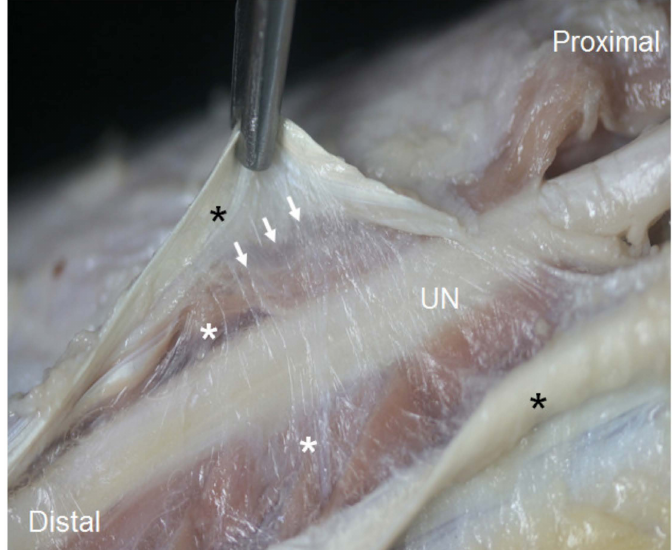
Figure 3. The UN in arm’s posterior compartment, after it crosses beneath the medial intermuscular septum. The white arrows mark the triceps brachii muscle’s epimysium in which the UN is involved, remaining attached to the medial head of triceps brachii (white asterisks). The black asterisks mark the membraniform tendon of this muscle, which has already been dissected.